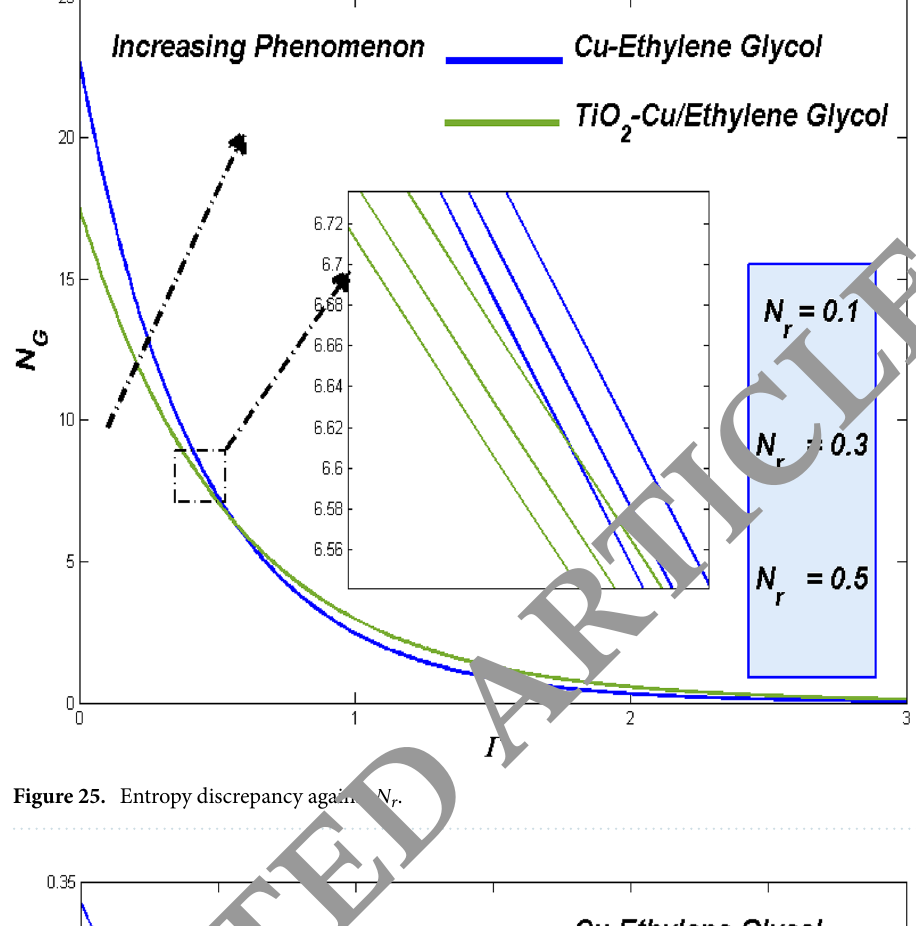
Figure 25. Entropy discrepancy against N r .